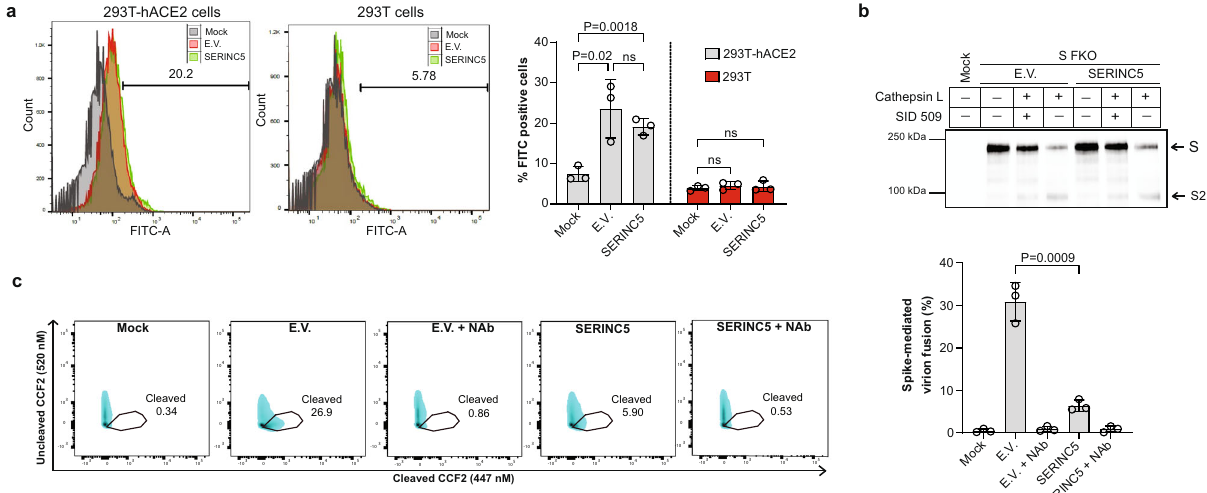
Fig. 4 SERINC5 blocks SARS-CoV-2 entry by targeting virus-cell membrane fusion. a SERINC5 does not affect SARS-CoV-2 S binding to ACE2 receptor. 293T-hACE2 or 293T cells were incubated on ice for 1 h with FITC-labeled SARS-CoV-2 S pseudovirions produced in the presence of either SERINC5 or empty vector (E.V.), shifted to 37 °C for 1 h and analyzed by FACS. Shown on the right are representative FACS plots and the graph on the left represents mean ± SD of % FITC positive cells from n = 3 independent experiments. Statistical signi fi cance was determined by unpaired t-test (two-tailed). 293T cells served as negative controls. b SERINC5 does not affect SARS-CoV-2 S priming by cathepsin L. SARS-CoV-2 S-FKO pseudoviruses produced in the presence of either SERINC5 or E.V. were incubated with 10 μ g/ml of cathepsin L for 1 h at RT with or without SID 26681509, a cathepsin L inhibitor. Samples were analyzed by immunoblotting using anti-FLAG antibody. Shown here is a representative immunoblot image from n = 3 independent experiments. Uncropped blots are in Source Data. c SERINC5 inhibits SARS-CoV-2 S-mediated fusion. 293T-hACE2 cells were infected with equal amounts of SARS-CoV-2 S pseudoviruses produced in the presence of either SERINC5 or E.V. Pseudoviruses pre-incubated with neutralizing SARS-CoV-2 S antibody were also included in these experiments. Cells were stained with CCF2-AM and then subjected to FACS. Fusion ef fi ciency was quanti fi ed as the percentage of cleaved CCF2. Representative FACS plots are shown on the right. The bars on the left represent mean ± SD of % cleaved CCF2 positive cells from n = 3 independent experiments. Gating strategies are shown in Supplementary Fig. 7. Statistical signi fi cance was determined by unpaired t-test (two- tailed). (empty vector, E.V.; SARS-CoV-2 Spike, S; SARS-CoV-2 Spike S2 subunit, S2; SARS-CoV-2 Spike-FKO, S FKO; SID 26681509, SID 509; Neutralizing Antibody, Nab; not signi fi cant,